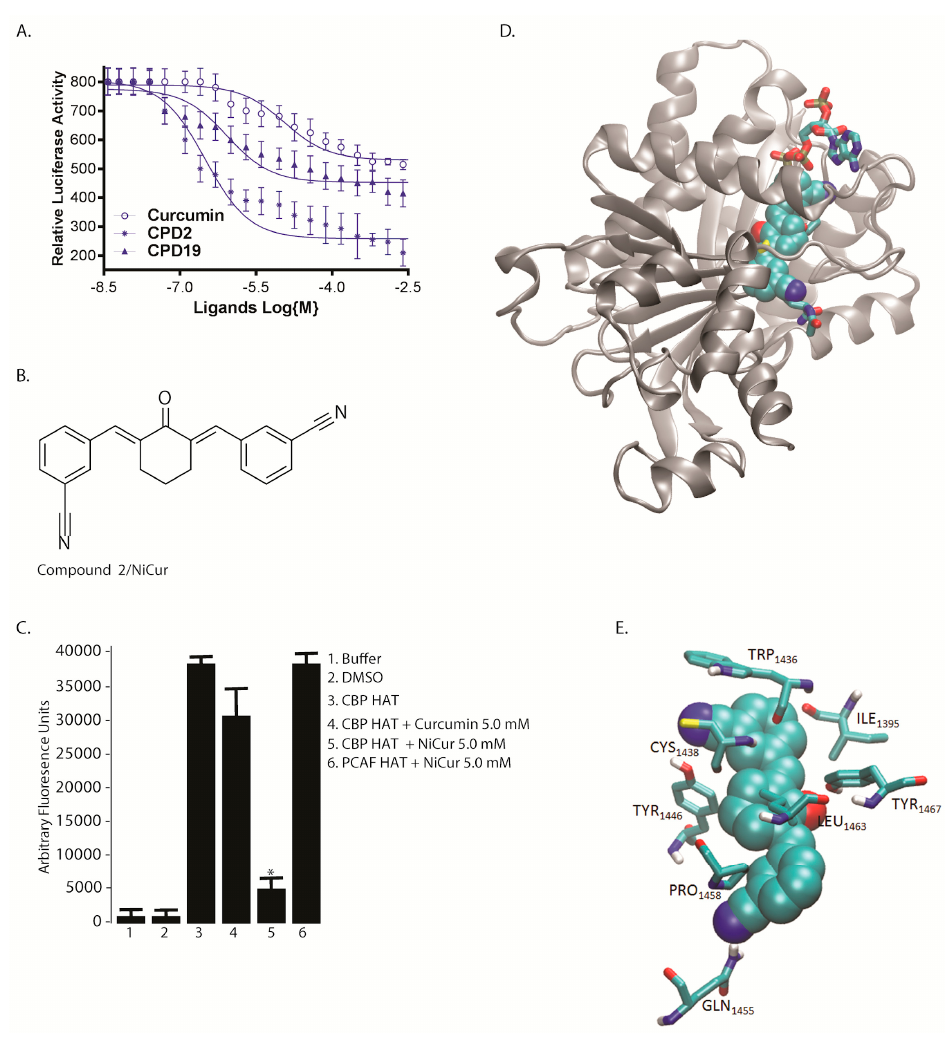
Figure 2. Biochemical characterization of compound 2 by cell-based assay and computational methods. ( A ) IC 50 was determined by a Dox treated luciferase-driven p53 reporter assay using curcumin and compounds 2 (CPD 2) and 19 (CPD 19) in a dose-dependent manner. RLU stands for relative luciferase units. The IC 50 values were calculated from three technical and biological repeats using the PRISM software; ( B ) Chemical structure of a cy - C 5 -curcuminoid-derived compound 2 that has been referred to as NiCur; ( C ) Relative inhibition of fluorescence-based in vitro CBP HAT activity in the presence of curcumin and NiCur at a concentration of 5.0 μ M respectively. The data show mean ± SEM ( n = 3 ), with significance at p < 0.05 or p < 0.01 indicated by * and **, respectively; ( D ) NiCur (spheres) binding pose and the peptide inhibitor (sticks) in the active site of CBP/p300 are highlighted and the ribbon diagram depicts the rest of the protein; ( E ) The residues of CBP (sticks) interacting with NiCur (spheres).